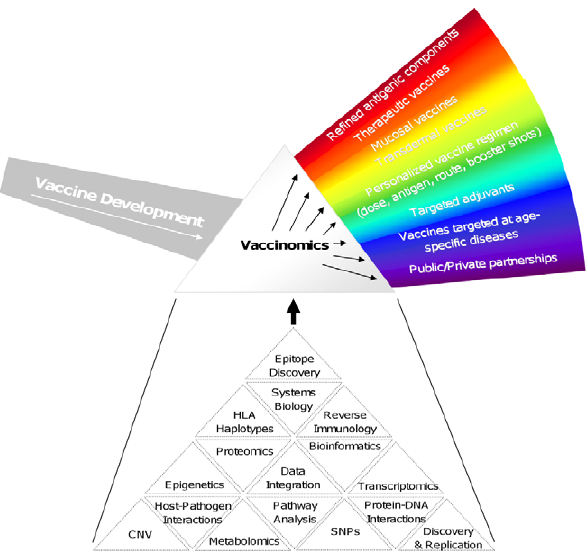
Figure 1. New approach to vaccine discovery and development. Figure 1 illustrates the differences between the one-size-fits-all approach of empiric vaccine development with a more directed and personal approach that relies upon vaccinomics and high-dimensional ‘‘omics’’ technologies. By analogy, empiric vaccine development represents the undifferentiated light entering the prism from the left. Individual aspects of directed vaccine development can be seen when viewed through the prism of vaccinomics. Several examples of these components are illustrated in the rainbow on the right side of the figure. These aspects may or may not be appropriate for all vaccines and are used here to illustrate the wide range of possibilities that a ‘‘discover – validate – characterize – deploy’’ approach allows one to independently investigate, optimize, and fully utilize. Below the vaccinomics prism are listed some examples (by no means complete or definitive) representing a range of potential components that can be assembled into a comprehensive, systems-level examination of infection/vaccination of a given pathogen. Please refer to the text for examples of how different components might be used in the development of specific